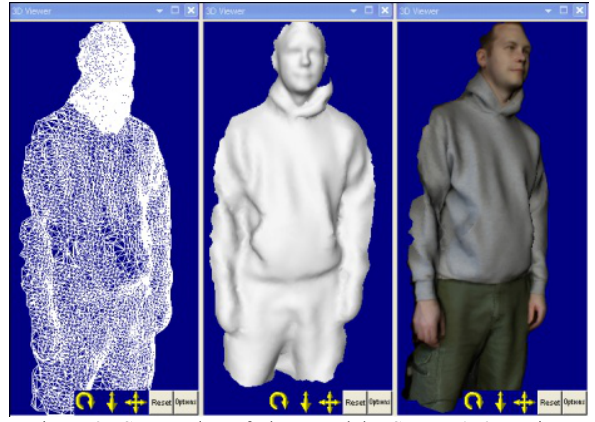
Figure 2. Screen shot of PhotoModeler Scanner's 3D. View showing a wire frame, shaded surface and textured surface of a full body scan done with two synced digital cameras and DSM. This parameter is translated into complex